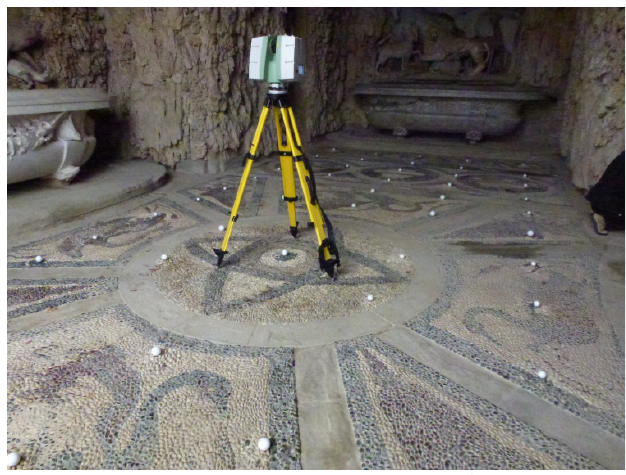
Figure 6. Foam balls on the nozzles in the floor.